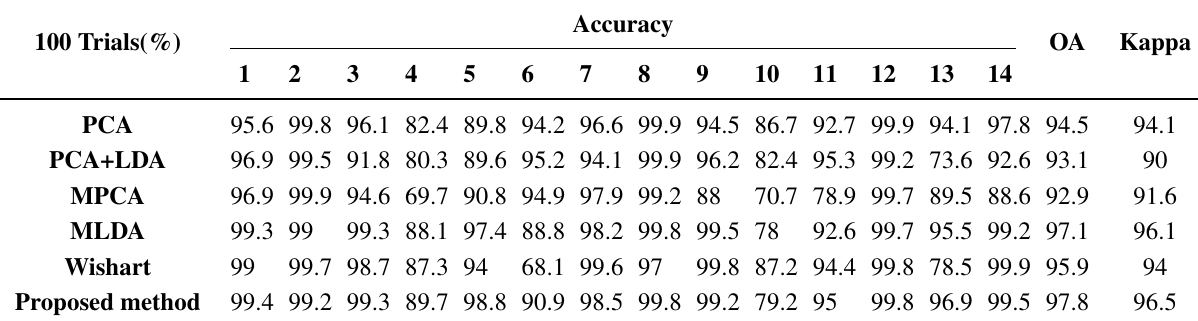
Table 2. The classification performance of the PCA only, LDA only, multi-linear principal component analysis (MPCA) only, multi-linear extension of linear discriminant analysis (MLDA) only, the proposed method and Wishart algorithm.